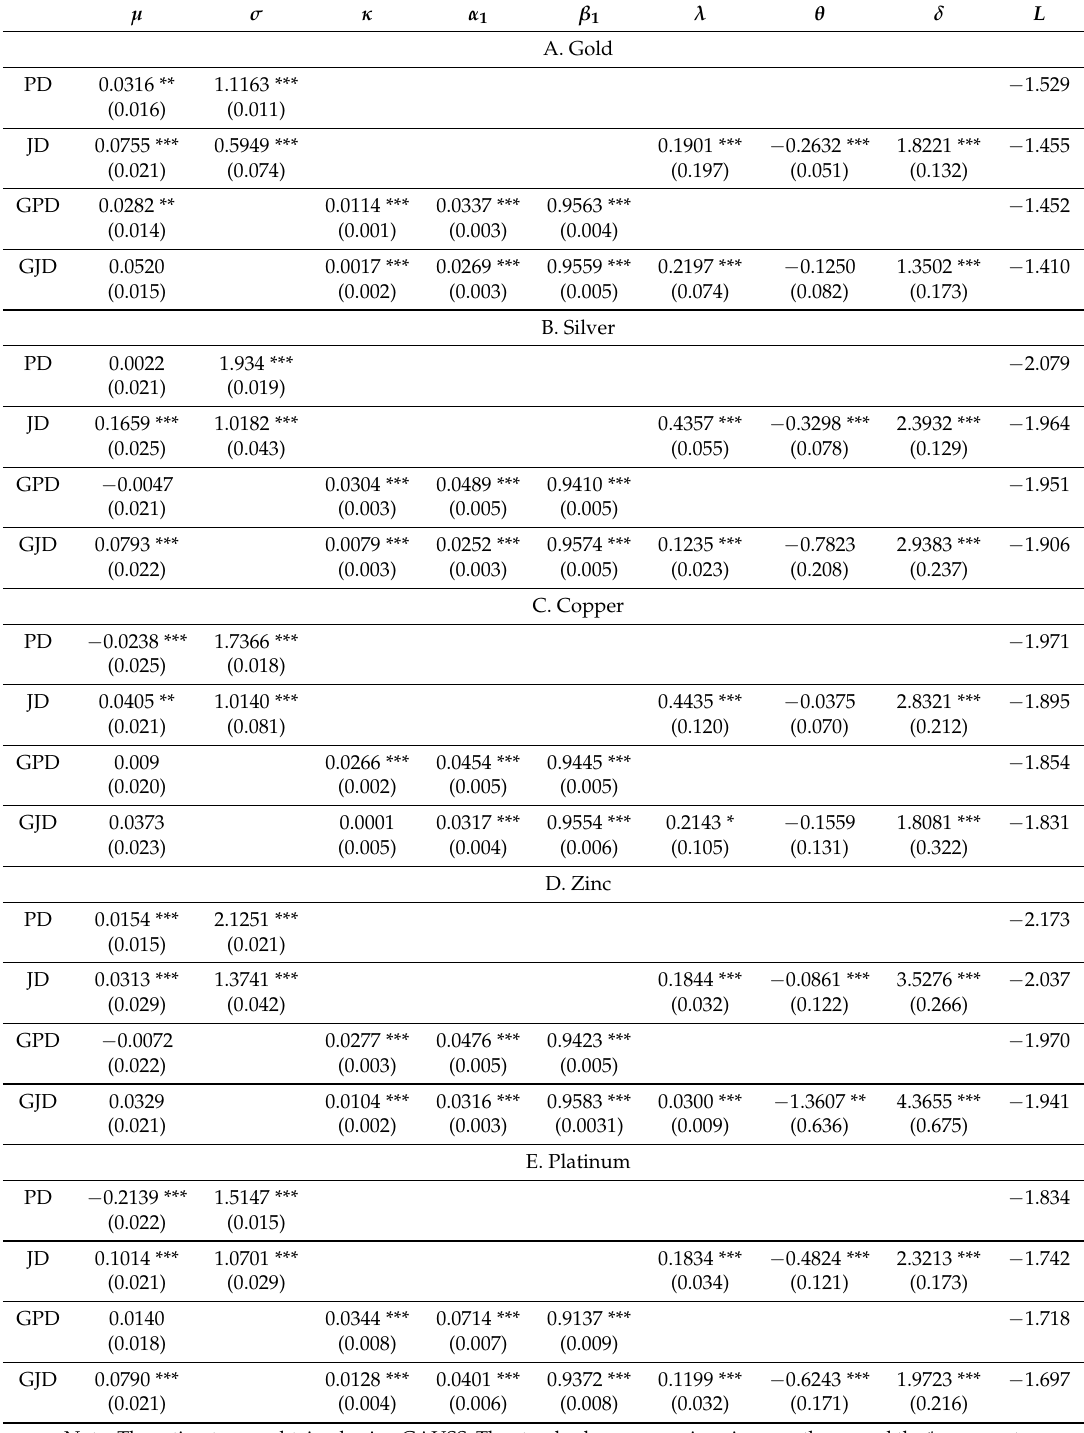
Table 2. Estimation of the model parameters for daily price